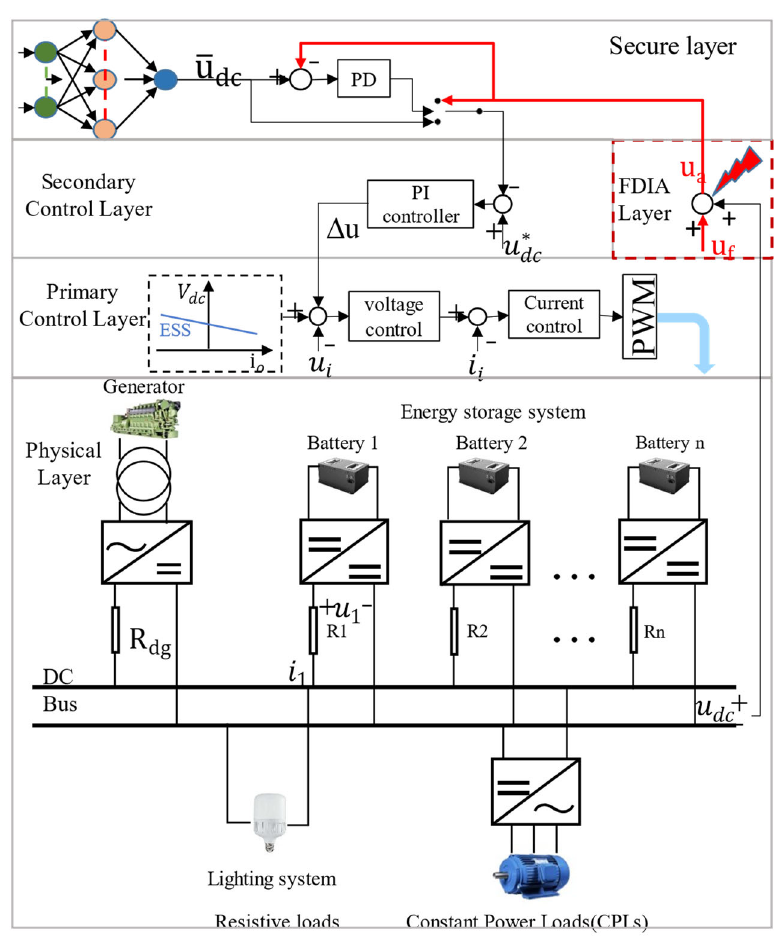
Figure 4. Implementation of an anti ‐ FDIA strategy based on the ANN.